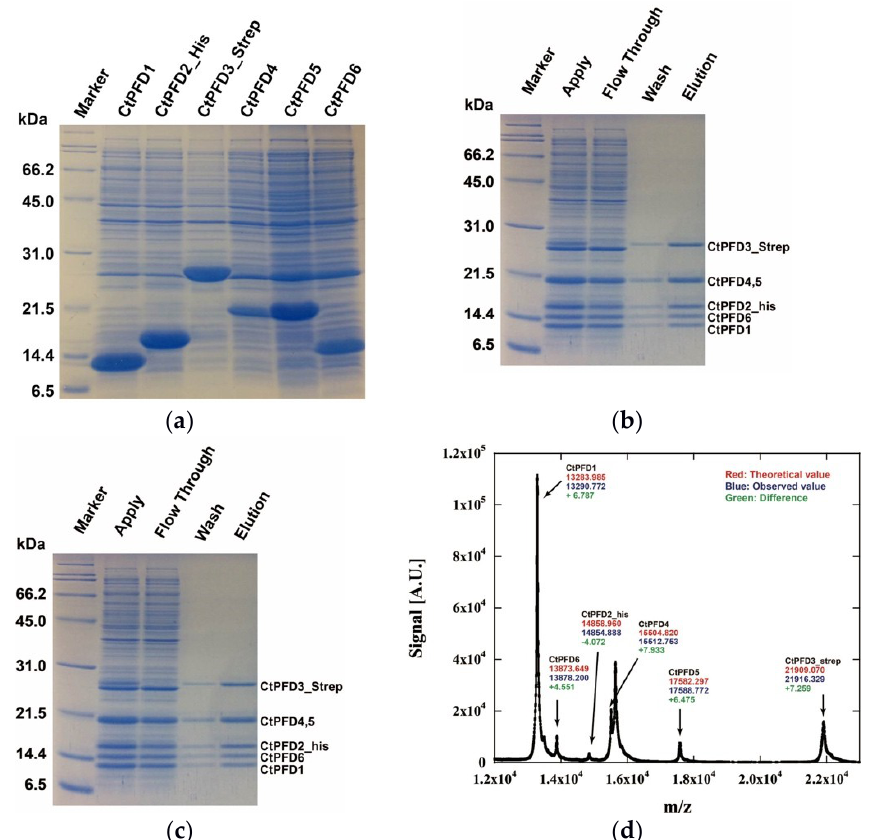
Figure 2. Expression, reconstitution, and purification of Chaetomium thermophilum ( CtPFD). ( a ) SDS-PAGE analysis of CtPFD subunit expression in E. coli . ( b ) SDS-PAGE analysis of the affinity purification of the CtPFD oligomer by StrepTrap HP. ( c ) SDS-PAGE analysis of the affinity purification of the CtPFD oligomer by His-Trap HP. ( d ) MALDI-TOF MS analysis of purified CtPFD. Peaks are annotated with the theoretical molecular mass (red), the observed molecular mass (blue), and the difference value (green).